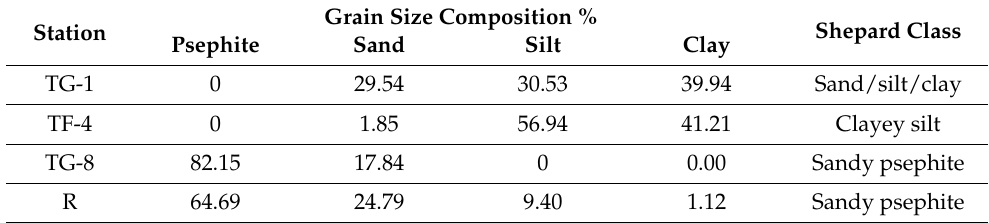
Table A2. Grain size composition of bottom sediments in Templefjord in front of the river (TG-1) near the glacier (TF-4), in permafrost (TG-8), and in riverine sediments (R) (June 2017). Station